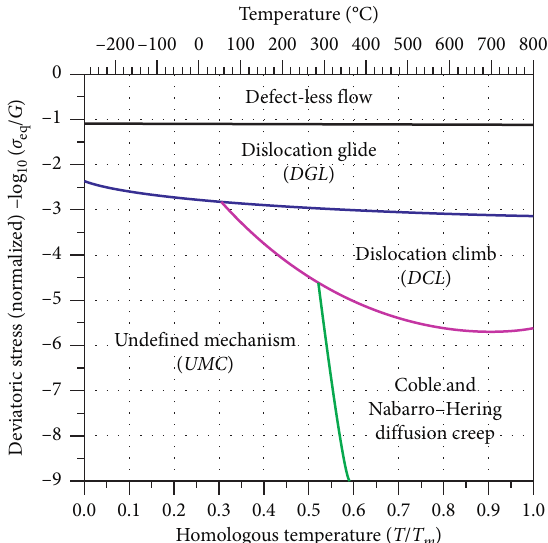
Figure 6: Deformation mechanism map for salt rock. G is the elastic shear modulus of salt, and T is the melting temperature of salt rock, adopted as 1077K [81,